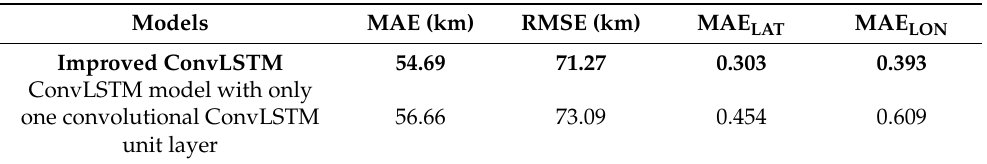
Table 3. Comparison of the results between the ConvLSTM model with only one convolutional ConvLSTM unit layer and the improved ConvLSTM model.